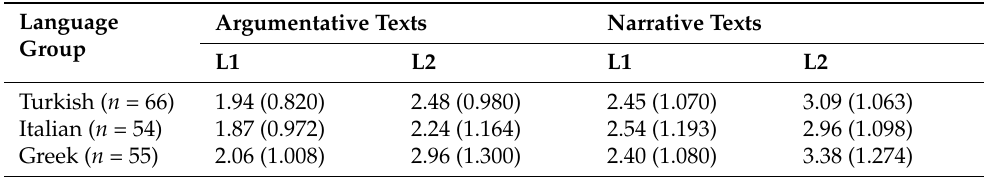
Table 2. Mean (SD) text level scores across language groups and languages in argumentative and narrative texts (scores between 1 and